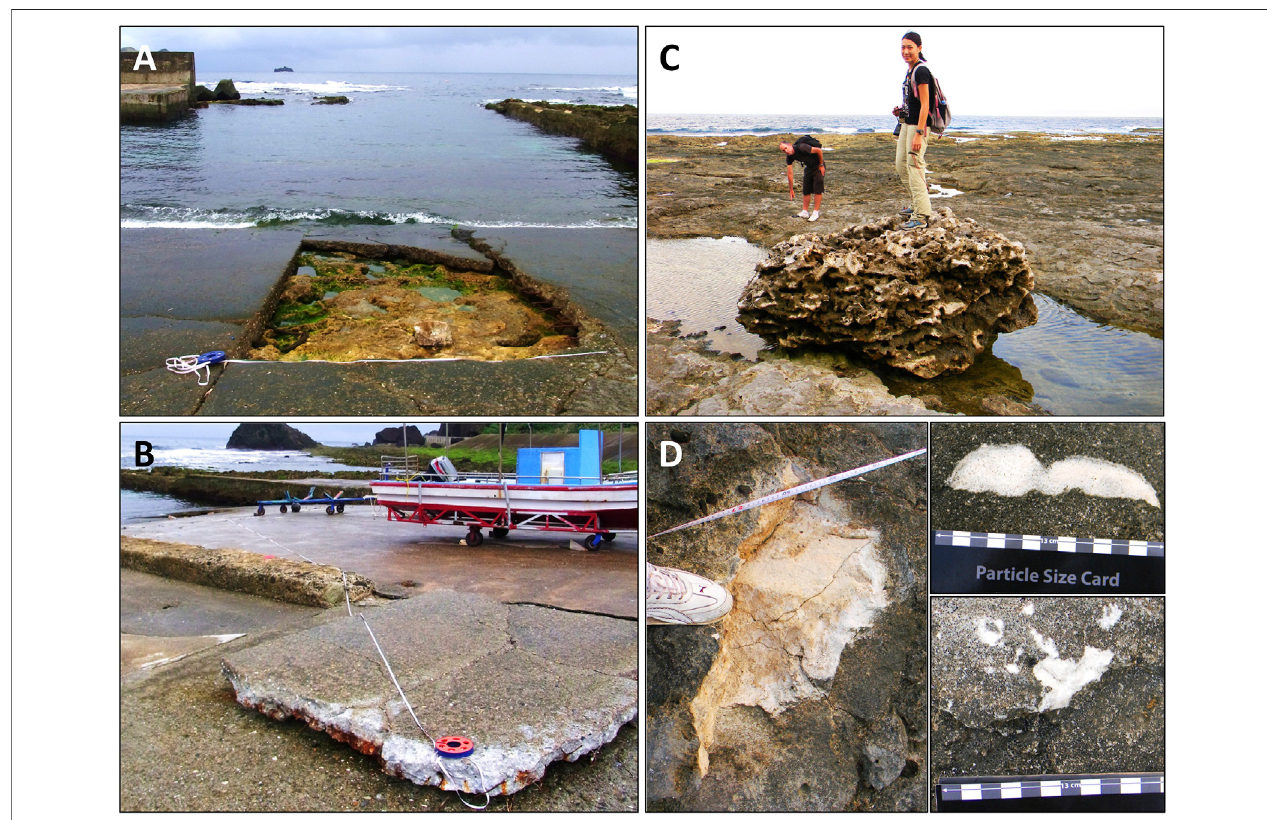
FIGURE11| Left:Damagetotheapronoftheboatramp (A) atthe fi shingharbourinWen CuenBaycausedbyTyphoonTembininAugust2012.Seenin (B) isthe 2.8 t concrete slab plucked out and rafted upslope by 20 m in a northwest direction. Right: Pre-existing 7.3 t limestone boulder (C) situated at the landward edge of a depression/tidal pool, which was remobilised during Typhoon Tembin. Fresh scars are present on all surfaces of the boulder, indicating overturning mode of wave transport. The person in the background is indicating various percussion marks on the reef surface (D) caused by impact of this boulder as it was transported across the reef platform. The farthest visible impact mark was found 30 m seaward, with the transport direction towards the southwest.